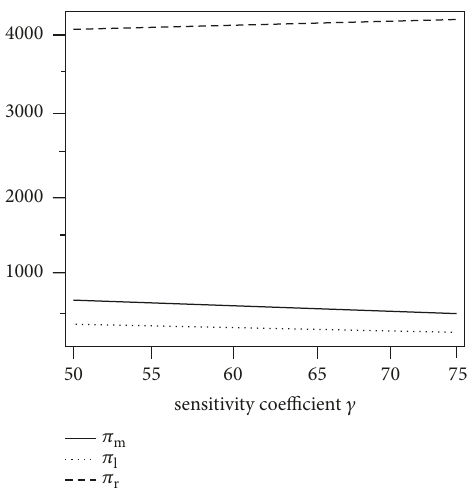
Figure3:Theeffectofthesensitivitycoefficientoftheorderquantity to the logistics service level on the supply chain members’